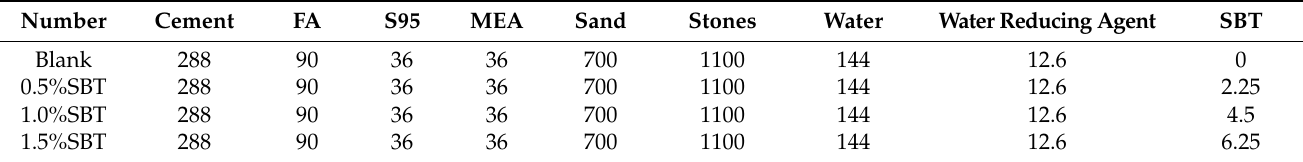
Table 2. Concrete proportioning (kg/m 3 ).